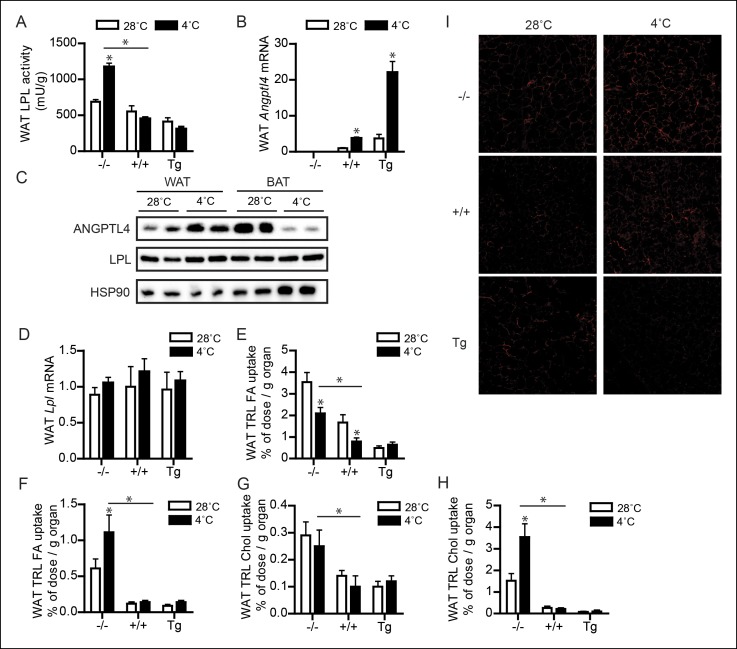
Up-regulation of ANGPTL4 in WAT upon sustained cold exposure suppresses WAT LPL activity and TRL-derived fatty acid uptake.(A) Total LPL activity levels and (B) Angptl4 mRNA in WAT of Angptl4-/-, wild-type and Angptl4-Tg mice exposed to 4°C or 28°C for 10 days. (C) Immunoblot for ANGPTL4 and LPL in WAT homogenates of wild-type mice exposed to 4°C or 28°C for 10 days. (D) Lpl mRNA in WAT of Angptl4-/-, wild-type and Angptl4-Tg mice exposed to 4°C or 28°C for 10 days. (E–H) Activity of 3H and 14C radiolabels in WAT of Angptl4-/-, wild-type and Angptl4-Tg mice exposed to 4°C or 28°C for 10 days and intravenously injected with radiolabelled VLDL-like (E,G) and chylomicron-like particles (F,H). TRL FA uptake (E,F) reflects uptake of glycerol tri[3H/14C]oleate, whereas TRL Chol uptake (G,H) reflects uptake of the core labels [14C]cholesteryl-oleate or [3H]cholesteryl-oleyloleate. (I) Fluorescent image of uptake of intravenously injected QD-TRLs into WAT of Angptl4-/-, wild-type and Angptl4-Tg mice exposed to 4°C or 28°C for 9 days. Image was taken after perfusion of mice with PBS containing 50 IU/mL heparin and upon cryosectioning of tissues. n = 2 mice per group. * Statistically significant compared to mice of equal genotype at 28°C or between groups as indicated by bars, according to two-way ANOVA followed by a post-hoc Tukey HSD test (p<0.05). Error bars represent ± SEM. n = 7–10 mice per group, unless otherwise indicated.